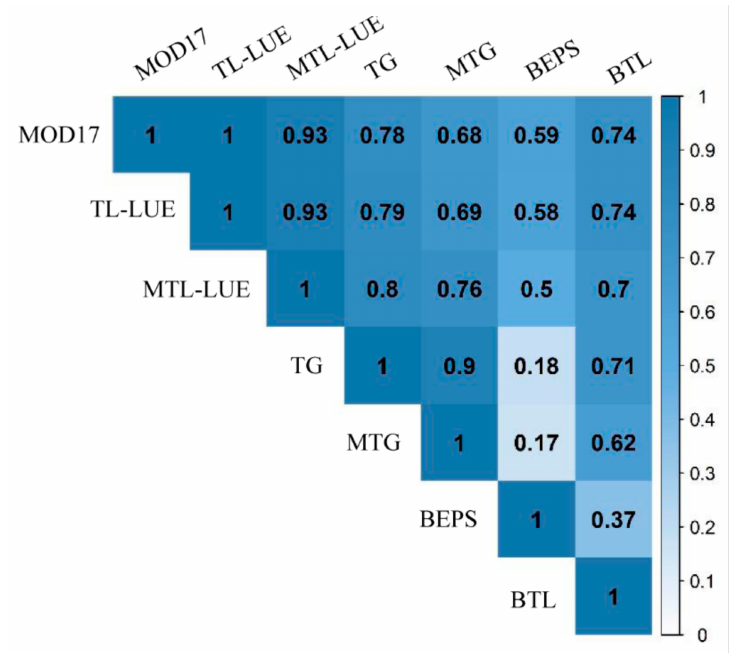
Figure 10. Color-coded correlation matrixes for annual GPP MTL-LUE , GPP TL-LUE , GPP MOD17 , GPP MTG , GPP TG , GPP BTL , and GPP BEPS over Wanglang Reserve. The correlation matrixes were calculated from the annual GPP maps of MOD17, TL-LUE, MTL-LUE, TG, MTG, BEPS, and